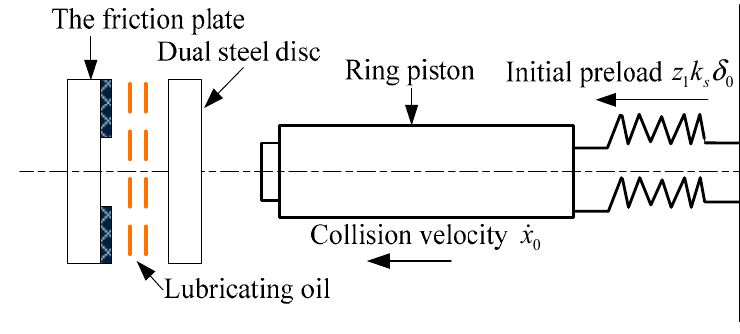
Clutch outer hub Figure 2. Three-dimensional model of a wet clutch 2.3. Analysis of Exercise Process The movement of the friction pair includes not only the process of moving the active disk axially toward the passive disk and squeezing the oil film, but also the relative rotation of the main and passive disks and a shearing of the oil film to realize the power transmission process [12]. Combined with the structural characteristics of an aviation friction clutch, the axial movement of an aviation wet clutch is divided into three processes. During the first stage, the piston begins to relieve the pressure, the spring at an equilibrium begins to return, and the spring preload force pushes the piston against the dual steel piece. During the second stage, the piston starts to contact the dual steel piece and collides. After the piston is in contact with the steel piece, according to the structural characteristics, a plastic collision occurs. After the collision, the piston moves together with the steel piece, and the displacement and